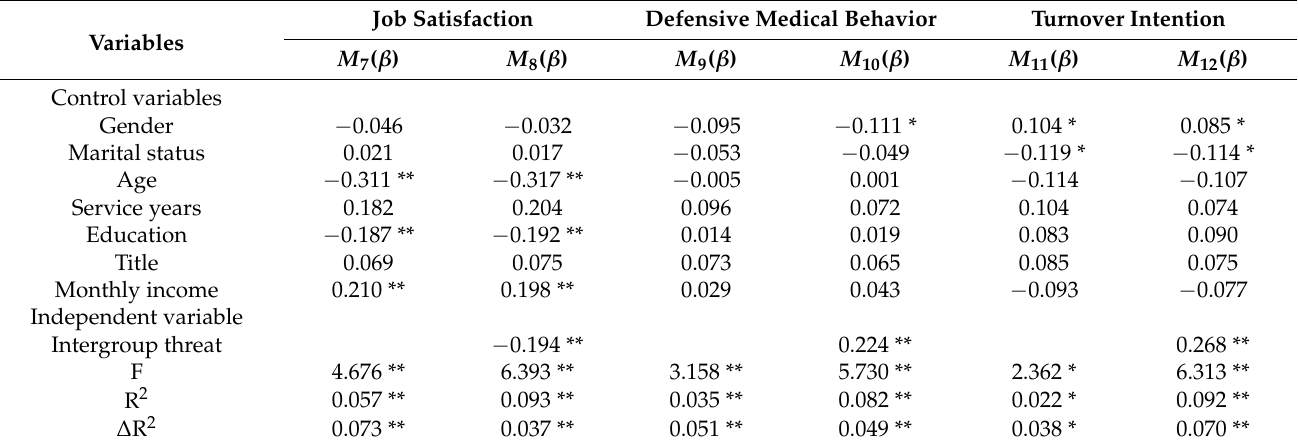
Table 7. Hierarchical linear regression models for organizational behavior and well-being ( n =